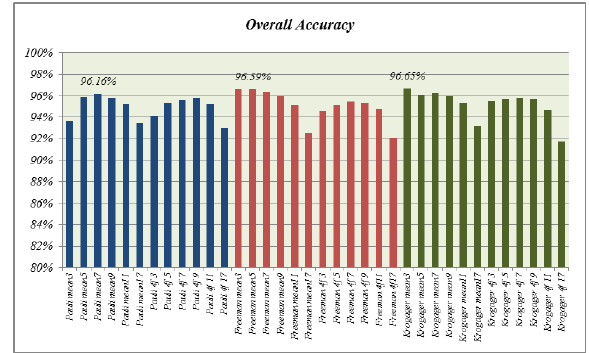
Figure 10. Overall accuracy of the SVM classification of Mean and combination of 4 features of Mean, Variance, Contrast and Dissimilarity of The Pauli, Krogager and Freeman decompositions.